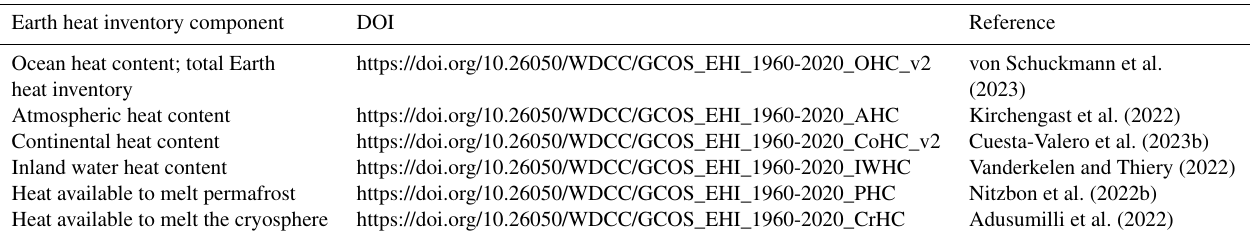
Table 4. Overview of Digital Object Identifiers (DOIs) for data access for the components of the Earth heat inventory and associated references. The results are presented in Fig.